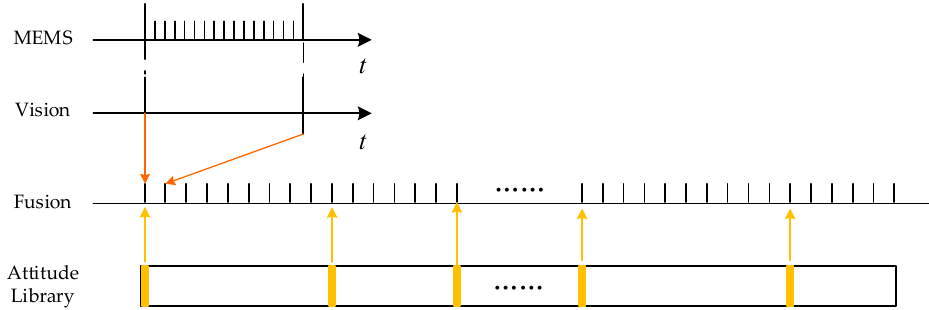
Figure 1. The working sequence of system.